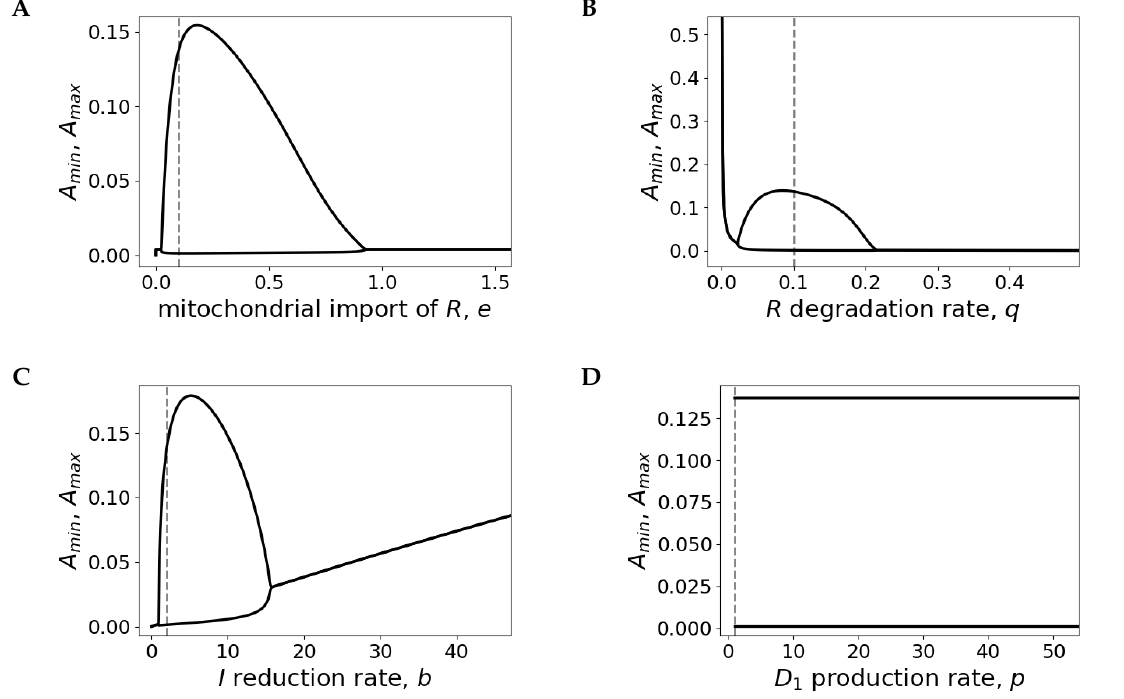
Figure A4. Bifurcation diagrams as a function of the model parameters e ( A ), q ( B ), b ( C ), and p ( D ). At e = 0.03, q = 0.025, and b = 1 self-sustained oscillations emerge. The system oscillates for any positive value of p . A min and A max represent the minimum and maximum values of A in the oscillatory regime. The curves are obtained for the default parameter set shown in the caption of Figure 4, by numerical integration of the model equations given in Figure 2B. The dashed gray lines refer to the default parameter